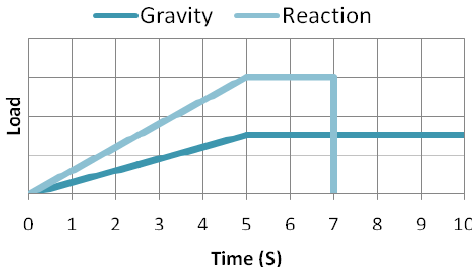
Fig. 6. Loading for dynamic column removal.